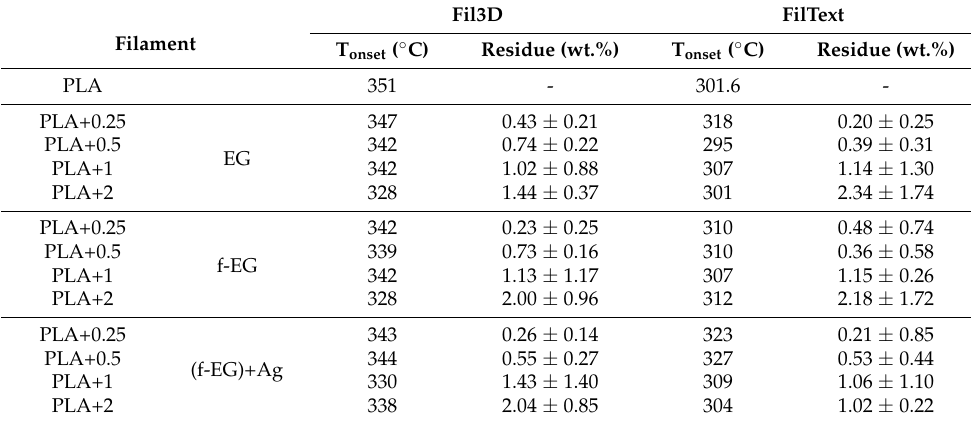
Table 1. Initial degradation temperatures of composite